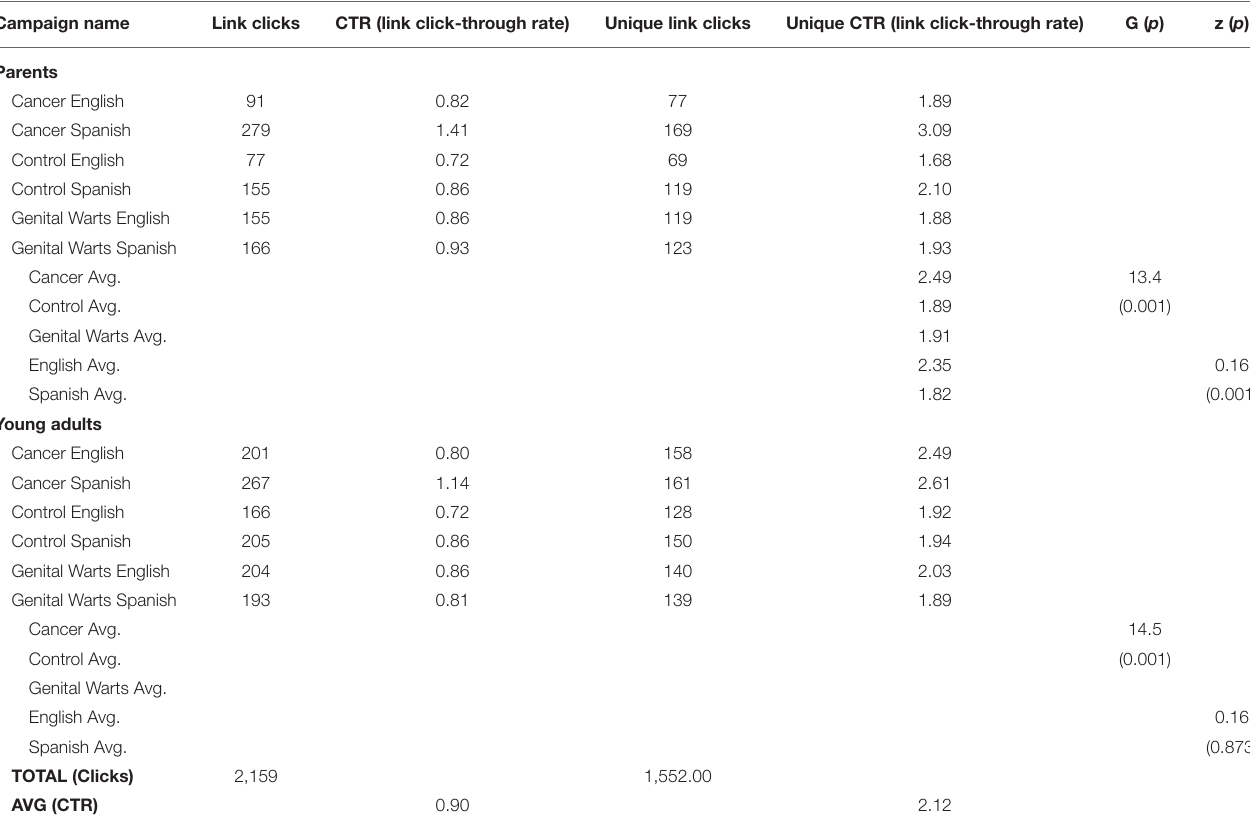
TABLE 2 | Facebook analytics for link clicks and CTR by message